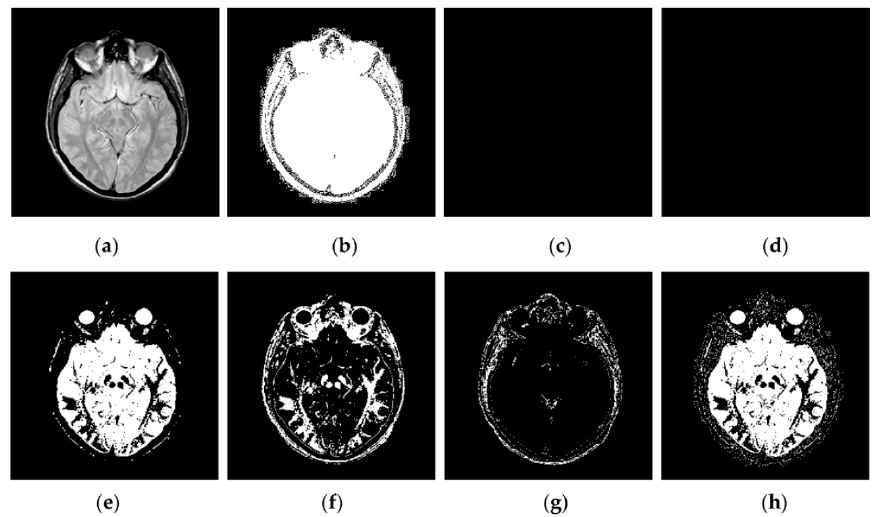
Figure 2. Temporal series of pulse outputs generated by the SCM operating on magnetic resonance (MR) image: ( a ) MR image; and ( b – h ) the binary pulse images from the first to the seventh iteration, respectively.